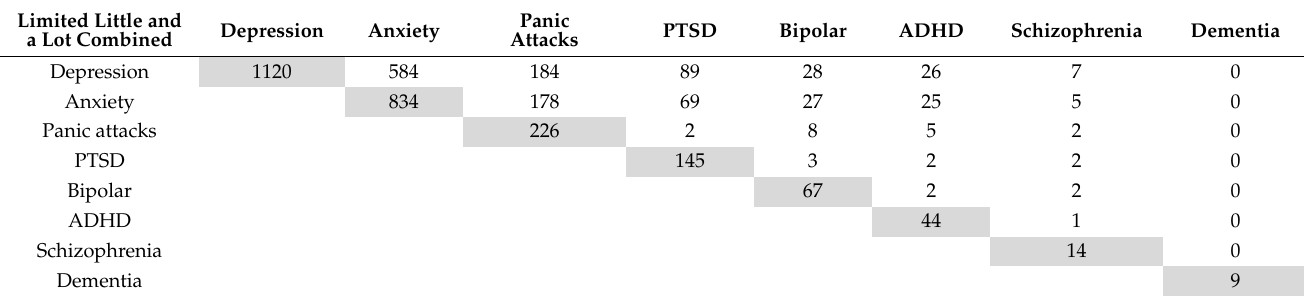
Table 3. Short Warwick–Edinburgh Mental Wellbeing Scale scores for those with and without specific mental health con- ditions who participated in parkrun as a runner/walker: statistical comparison used the Mann–Whitney U test.